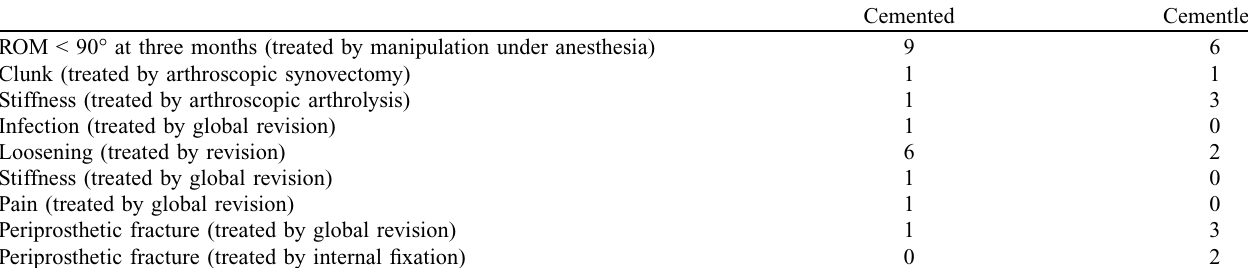
Table 3. Complications.